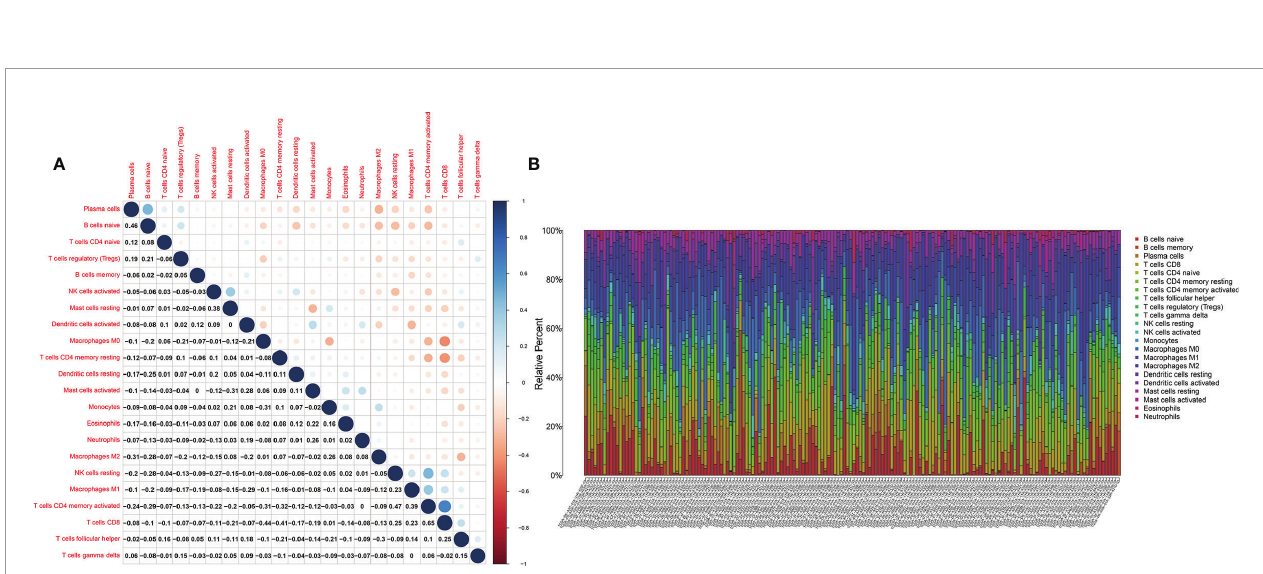
FIGURE 11 | The tumor-in fi ltrated immune cell pro fi le in BLCA samples and correlation analysis. (A) Barplot showing the proportion of 21 types of tumor-in fi ltrating immune cells in BLCA samples. (B) Heatmap showing the correlation between the 22 types of tumor-in fi ltrating immune